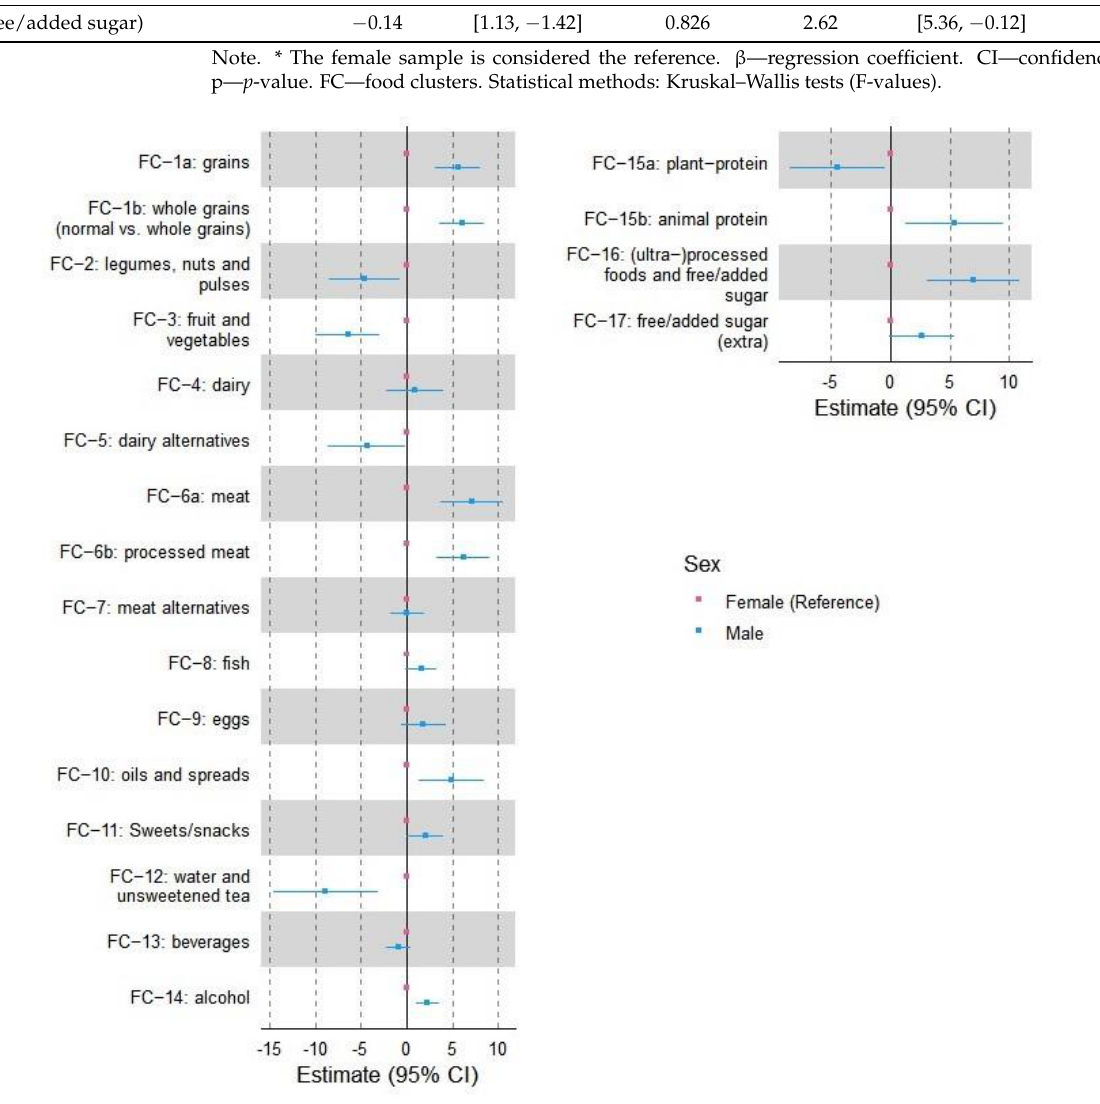
Table 4. Regression results for age- and sex-based interactions in food clusters. Age